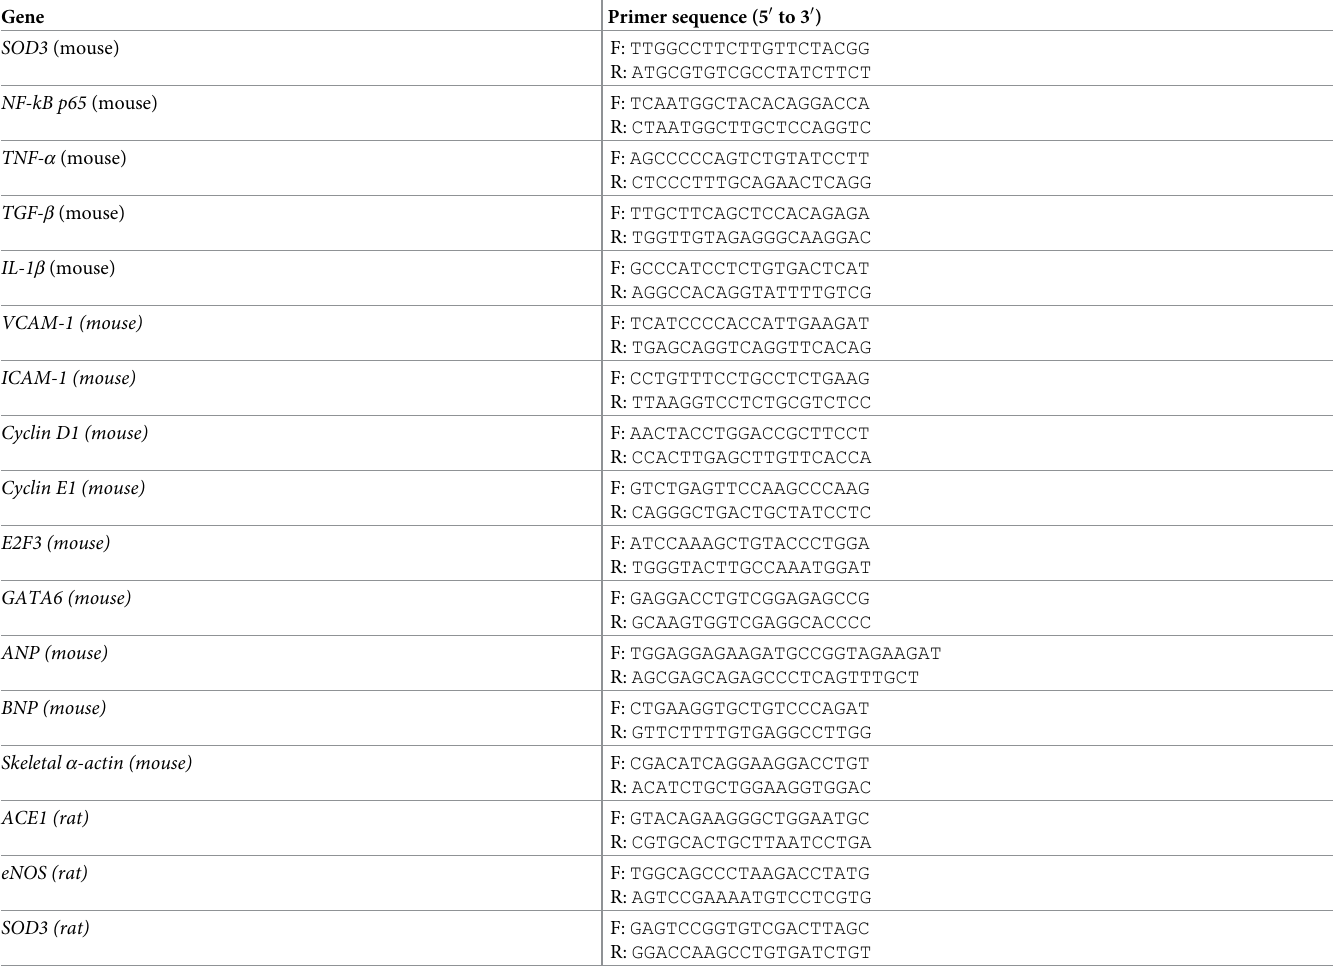
Table 2. Primers for reverse transcription-polymerase chain reaction (RT-PCR).